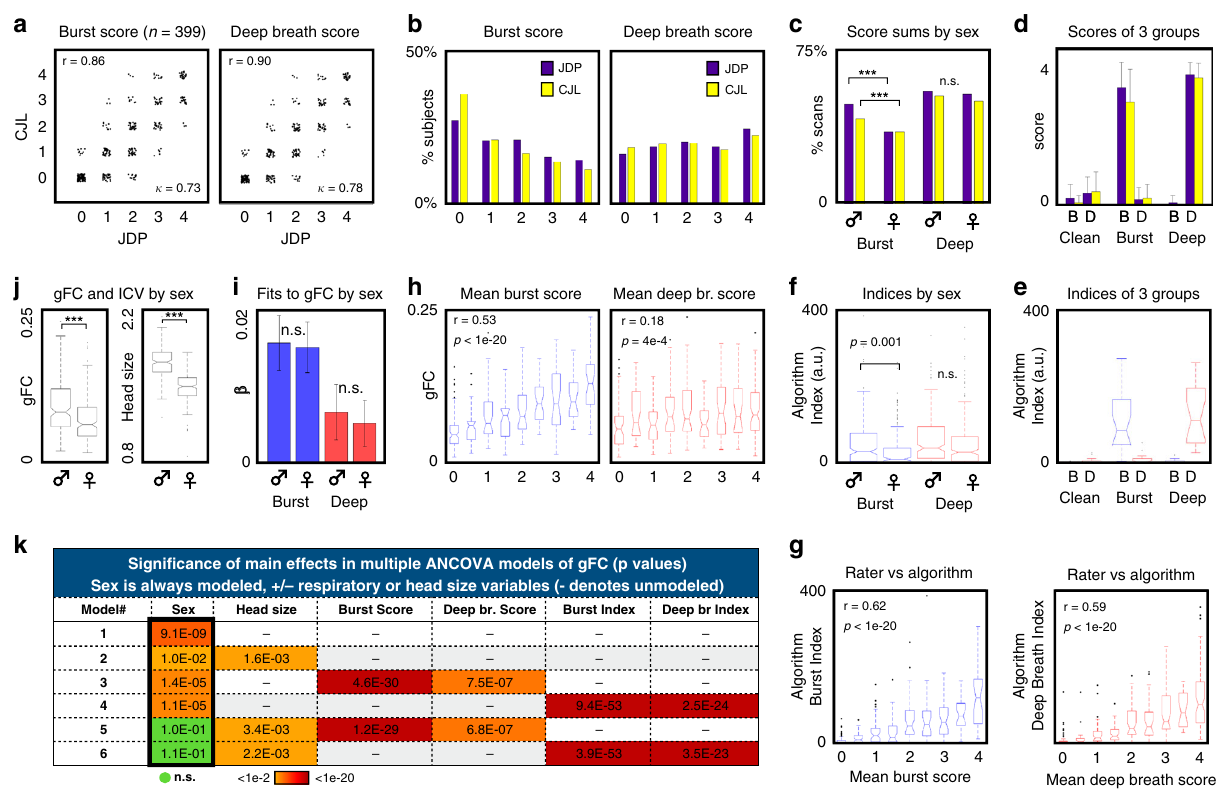
Fig. 4 Rater scorings and algorithmic indices detect sex effects and global functional connectivity in fl uences. a Plots of total scans (of 4) with bursts and deep breaths for both raters, with score correlations and Cohen ’ s kappas inset, for N = 399 subjects (all panels display results from N = 399 subjects except d and e , which concern the three 21-subject groups). b Histograms of scores across subjects for both patterns, showing raters by color. c Bar graph of percent scans of each sex displaying patterns. Chi-squared tests of bursts yield p = 3.4e − 8 and 8.8e − 7 for J.D.P. and C.J.L. (denoted by ***), effects unchanged by excluding members of the three groups. No signi fi cant differences are seen by sex in deep breath scores. d Bar plots showing mean values with std error bars of the ratings in a clean, burst, and deep breath groups (each with N = 21 unrelated subjects). B and D denote burst and deep breath. Desired respiratory properties are found in each group. e Algorithm indices of the three 21-subject groups, corroborating rater scores and con fi rming desired breathing patterns (compare with d directly above). Box plots show median and 25th and 75th percentiles as boxes, whiskers encompass 99% of normally distributed data, outliers are individually marked (all box plots in later panels follow this format). f Algorithm indices of breathing patterns by sex, with signi fi cant differences by two-sample t -test in bursts but not deep breaths (compare with c directly above). g Box plots of algorithm indices for each pattern as a function of mean rater score, demonstrating signi fi cant Pearson correlations of humans and algorithm ratings. h Box plots of gFC as a function of mean pattern scores, showing much stronger effects of bursts on gFC, quanti fi ed by Pearson correlation. i Betas of multiple linear regression of pattern scores in gFC (gFC = b0 + b1*burst_score + b2*deep_breath_score), performed in each sex separately, showing much stronger effects of bursts. Bars show mean values, error bars show 95% con fi dence intervals; fi ts do not differ by sex (both n.s. by two-sample two-sided t -test, uncorrected for multiple comparisons). j Box plots of gFC and head size (intracranial volume, ICV) by sex, both signi fi cantly different by sex by two-sample two-sided t -test ( p = 9.1e − 9 and <1e − 20, respectively). k Color chart of signi fi cance of main effects of multiple ANCOVA models. Sex effects become insigni fi cant when both head size and respiratory variables are modeled. Source data are provided as a source data fi le, though group identity is values of 0.73 and 0.78 overall. Due to the number of ambiguous excluding the groups mentioned above. Overall, bursts were decisions that must be made in subtle instances of patterns, or identi fi ed in 45% of male scans and 35% of female scans, whereas amidst disorganized and chaotic breathing styles, we prioritized deep breaths were identi fi ed in 54% of male scans and 52% of the totals over four scans in each subject, referred to as pattern female scans. Scores of each pattern were uncorrelated across all scores. These scores correlated at r = 0.86 ( p < 1e − 20) for bursts subjects, for each rater, and within each sex ( r < 0.1 for all). Thus, and 0.90 ( p < 1e − 20) for deep breaths between raters, illustrated the breathing patterns appear to occur independently across subjects. The pattern scores within the 3 previously contrasted recognize the breathing patterns; interested readers may use the groups accord with the desired group breathing properties Supplementary pattern training module to learn the patterns (Fig. 4d). (download at https://osf.io/u35f8/). Deep breaths occurred in about 85% of subjects, and it was common for subjects to display deep breaths in most or all scans (Fig. 4b). Bursts, on the other hand, were absent in about 30% of bursts in all scans. In both sets of ratings, chi-squared tests for sex differences were signi fi cant for bursts ( p = 3.4e − 8 and 8.8e − 7) but not for deep breaths (Fig. 4c), effects unchanged when